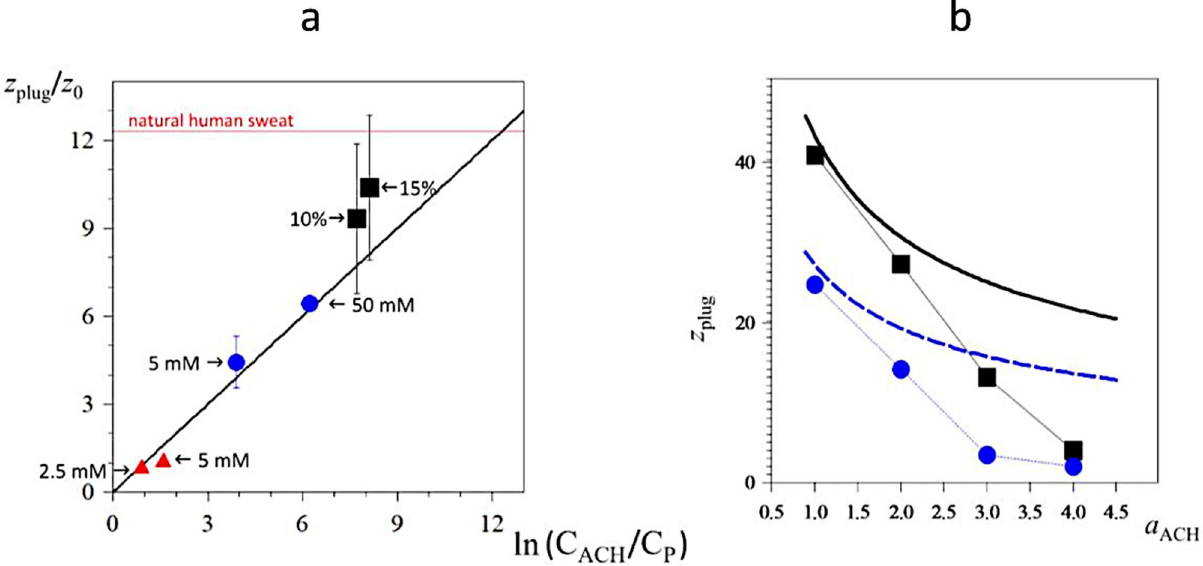
Figure 8. ( a ) Reduced plug position, z plug / z 0 , with the parameter z 0 as given in (1), versus the natural logarithm of the sources ratio C ACH /C P (the thick black line is the Eq. (1)). Black squares: experimental results shown on Fig. 4a for ACH concentrations 10% and 15%, and value of C P = 15 μM (parameters used to calculate the value of z 0 : d o = 59 μm (diameter of the disk of same area as a rectangle of edges 50 μm and 55 μm), a ACH = 1 nm, v P = 200 μm s −1 ). Blue circles: results from the 1D numerical code for ACH concentrations 50 mM and 5 mM, and C P = 100 μM (parameters: d o = 20 μm, a ACH = 1 nm, v P = 100 μm s −1 ). Red triangles: results shown on Fig. 7a, from the 3D numerical code for ACH concentrations 5 mM and 2.5 mM, and C P = 1 mM (parameters: d o = 0.26 μm, a ACH = 1 nm, v P = 20 μm s −1 ). The error bars correspond to the upper and lower extension of the plug in each experiment. ( b ) Mean gel localization inside sweat channel versus hydrodynamic radius of molecular aggregating species in the 1D numerical simulation model. Sizes of cylindrical sweat channel: d o = 20 µm and 200 µm length. Sweat flows in the pore at constant 100 μm s −1 encountering aggregating species of coordinence 4 with different hydrodynamic radius at C ACH = 5 mM (blue circles) or C ACH = 50 mM (black squares). In this simulation, proteins (C P = 0.1 mM) are considered as 3 nm particles with coordinence 5. The black thick curve is the Eq. (1) in the case of ACH concentration equal to 50 mM, and the dashed blue curve is for the 5 mM ACH concentration. There is no adjustable parameter. Agreement between Eq. (1) and 1D numerical simulations is excellent when plug forms well inside the pore, but poor when plug forms nearby pore output (because of the difficulty to define z plug when part of the gel is located outside the